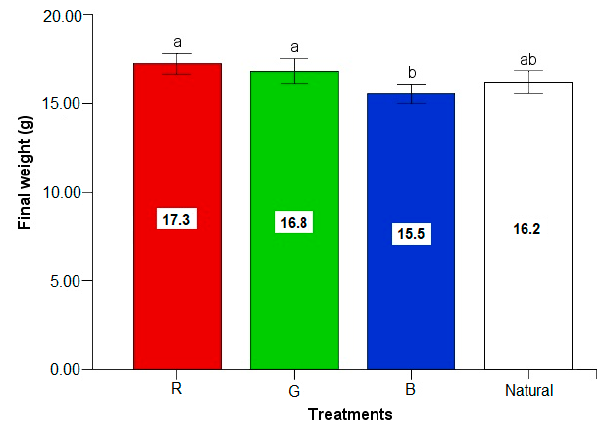
Figure 3. The mean final weight of the fish in each treatment. Each bar represents the mean with the standard deviation. Different letters (such as a, b, and ab) represent significant differences ( p < 0.05).